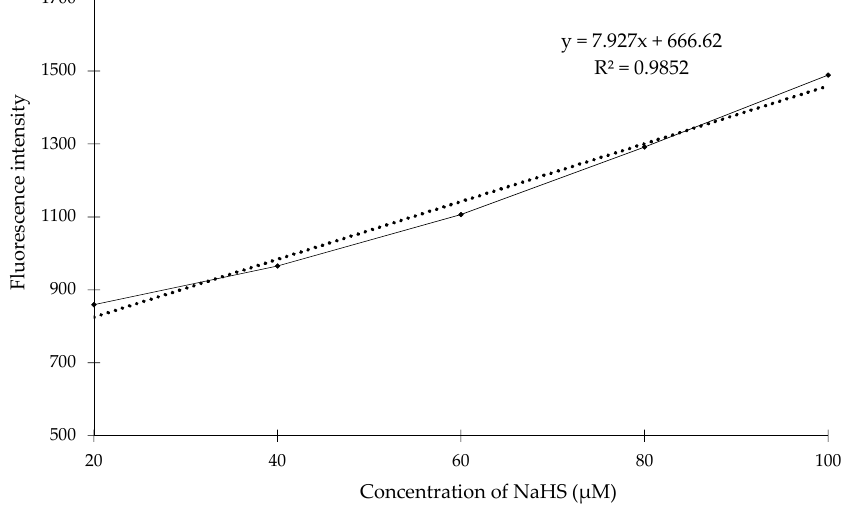
Figure 10. The correlation between fluorescence intensity and NaHS concentration determined using a fluorometer: the compound 1 (0.1 mM) with NaHS (20–100 μ M) in sodium phosphate buffer ( λ ex = 365 nm) at room temperature. The points represent the mean fl uorescence responses at 10 min after the addition of NaHS.